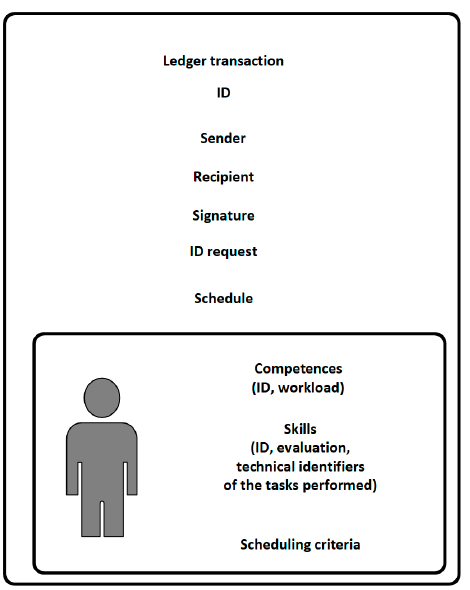
Figure 6. The content of the employee competency assessment in response to an open tender. Each new book begins with a block named Genesis Block, which specifies the beginning and imposes the necessity to add additional blocks to the chain. An example blockchain for four employees selection by consensus to execute four subsequent orders (open tenders) is shown in Figure 7. In each book, the procedure for responding to a new order for an employee and building consensus is repeated.